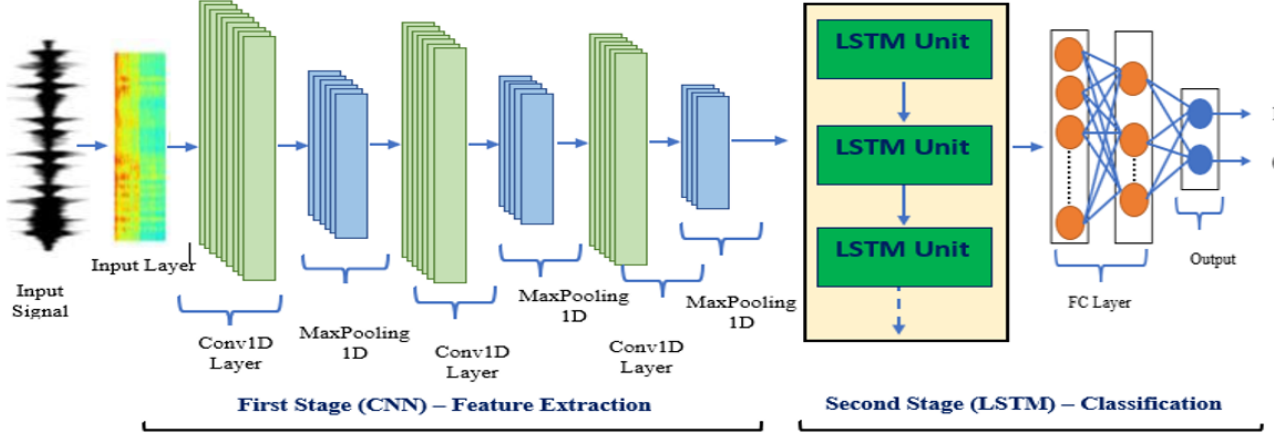
Figure 5. An instance of a 1D-CNN-LSTM model. Table 2. The datasets sample corona and non-corona in the time